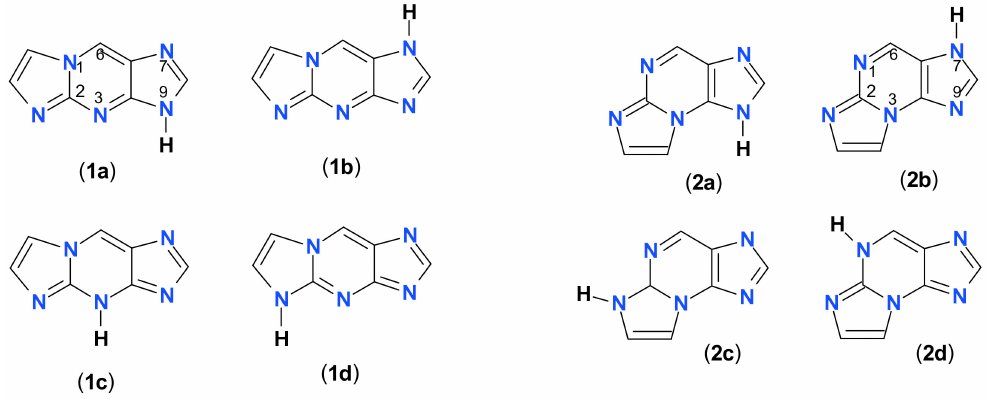
Figure 12. Possible tautomeric structures of two isomers of etheno-2-aminopurine: 1,N 2 -etheno-2- aminopurine ( 1a – d ), N 2 ,3-etheno-2-aminopurine ( 2a – d